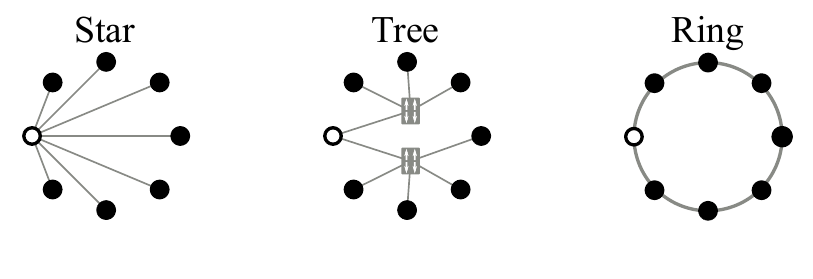
Figure 1. Network